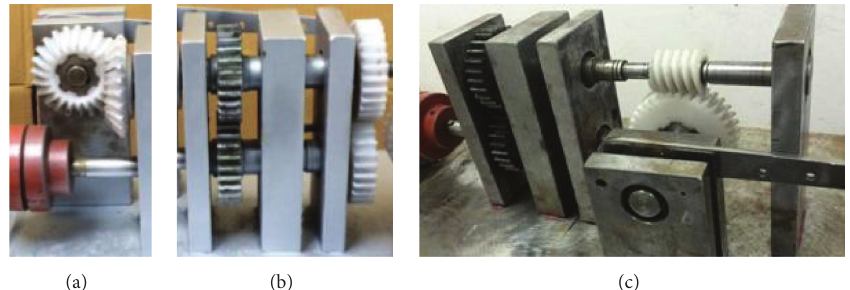
Figure 5: Photograph views for (a) bevel gear testing unit, (b) spur/helical gear testing unit, and (c) worm gear testing unit.